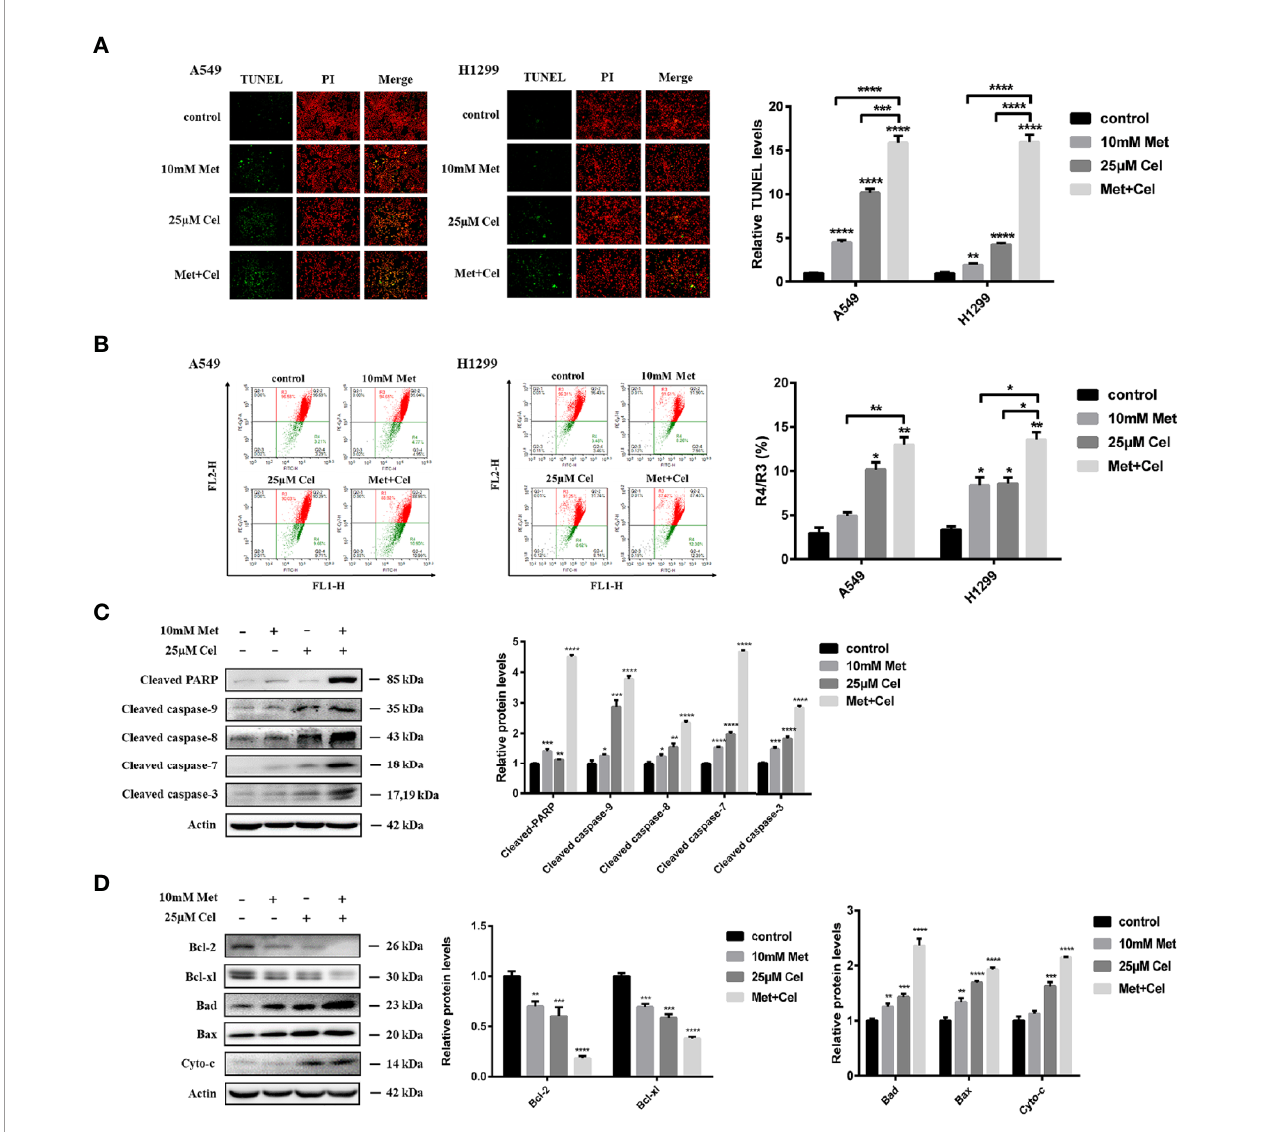
FIGURE 3 | Apoptosis of NSCLC cells induced by celecoxib combined with metformin. (A) Detection of apoptosis in A549 and H1299 cells treated with 10 mM metformin and/or 25 m M celecoxib for 48 h by TUNEL assay. (B) Detection of MMP in A549 and H1299 cells treated with 10 mM metformin and/or 25 m M celecoxib for 48 h by JC-1. (C) Activation of PARP, caspase-9, caspase-8, caspase-7, and caspase-3 was detected by WB analysis in A549 cells under different treatment conditions. All gels run under the same experimental conditions and the representative images of three different experiments were cropped and shown. Band intensity was quanti fi ed by Image J software. (D) Expressions of the Bcl-2 family proteins, Bcl-2, Bcl-xl, Bad, Bax, and Cyto-c in A549 cells under different treatment conditions were detected by WB analysis. All gels run under the same experimental conditions and the representative images of three different experiments were cropped and shown. Band intensity was quanti fi ed by Image J software. Data are represented as mean ± SD. * p < 0.05, ** p < 0.01, *** p < 0.001, **** p <